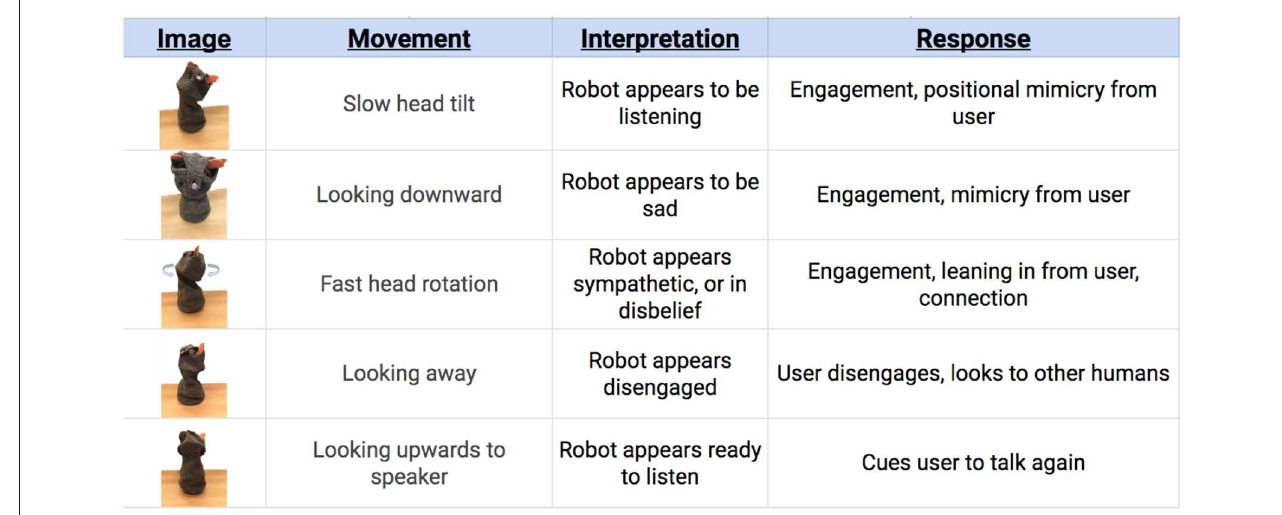
FIGURE 6 | Blossom operator behaviors and associated responses.